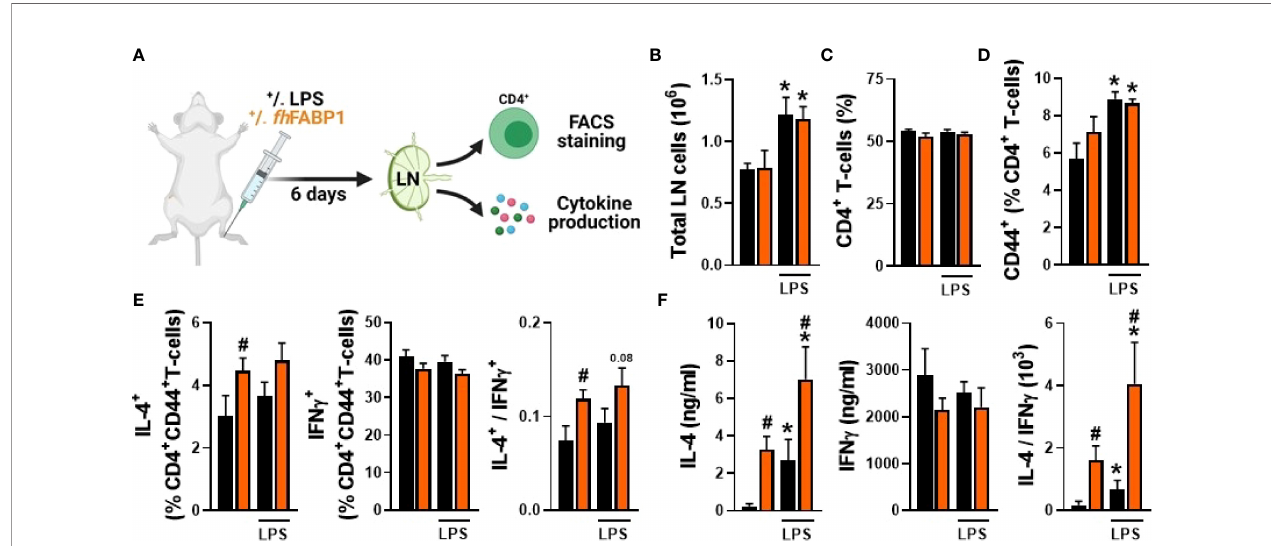
FIGURE 7 | Fasciola hepatica FABP1 modulates T cell polarization in vivo . Mice were injected sc into the hind hock with PBS (black bars) or 25 µg recombinant fh FABP1 (orange bars) together with or without LPS (200 ng) The draining popliteal lymph nodes (LNs) were collected after 6 days for FACS analyses and ex vivo restimulation of LN cells (A) The total LN cells count (B) and the frequencies of CD4 + T cells (C) and CD4 + CD44 high effector T cells (D) were determined The percentages of IL-4 + , INF g + and IL-10 + cells within the CD4+CD44 high effector T cell population were also assessed, and the IL-4-on- IFN g ratio plotted (E) Alternatively, part of the LN cells were re-stimulated ex vivo and secretion of IL-4 and IFN g were measured by cytokine bead assay (F) . Results are expressed as mean ± SEM * P ≤ 005 vs LPS alone, # P ≤ 005 vs PBS (n=3-5 mice per